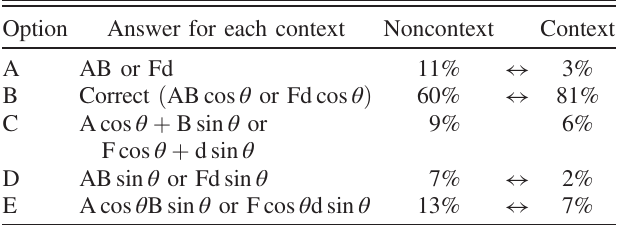
TABLE V. Results of item 4: Students have to calculate the dot product of two vectors as AB cos θ or the work done by a force in a displacement as Fd cos θ . Arrows indicate significant